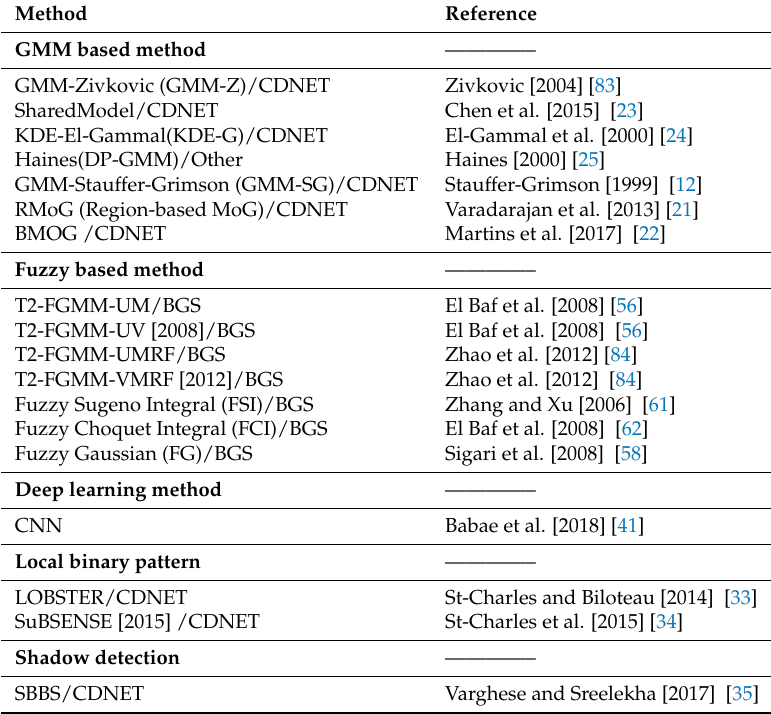
Table 7. Methods used in the comparative study.